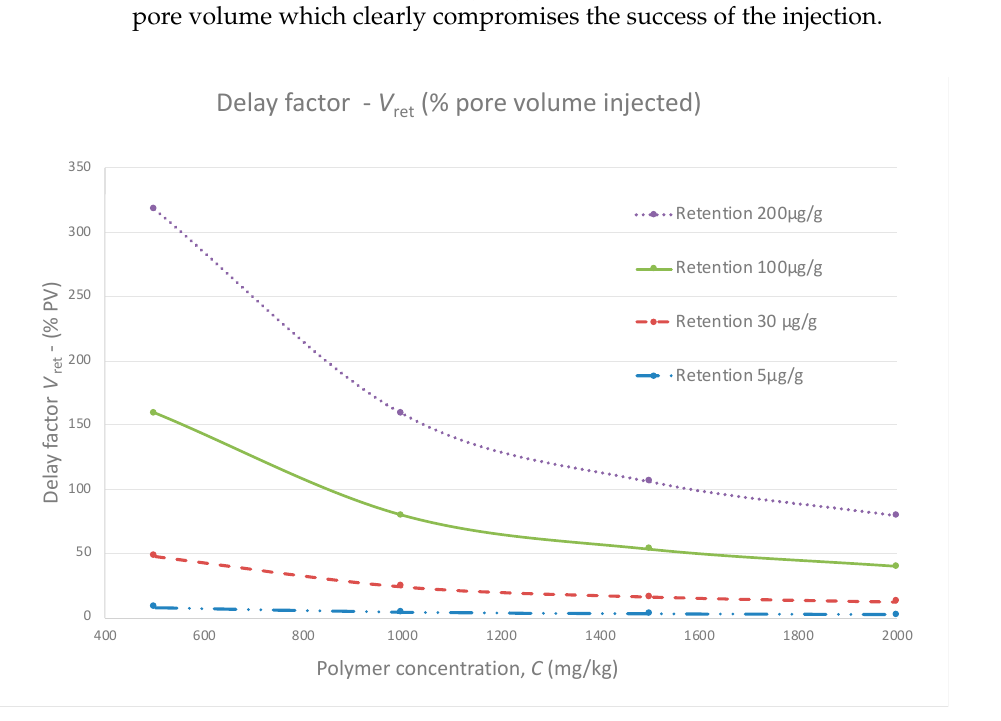
Figure 1. Examples of calculations of oil bank delay vs. retention and polymer concentrations val- ues.